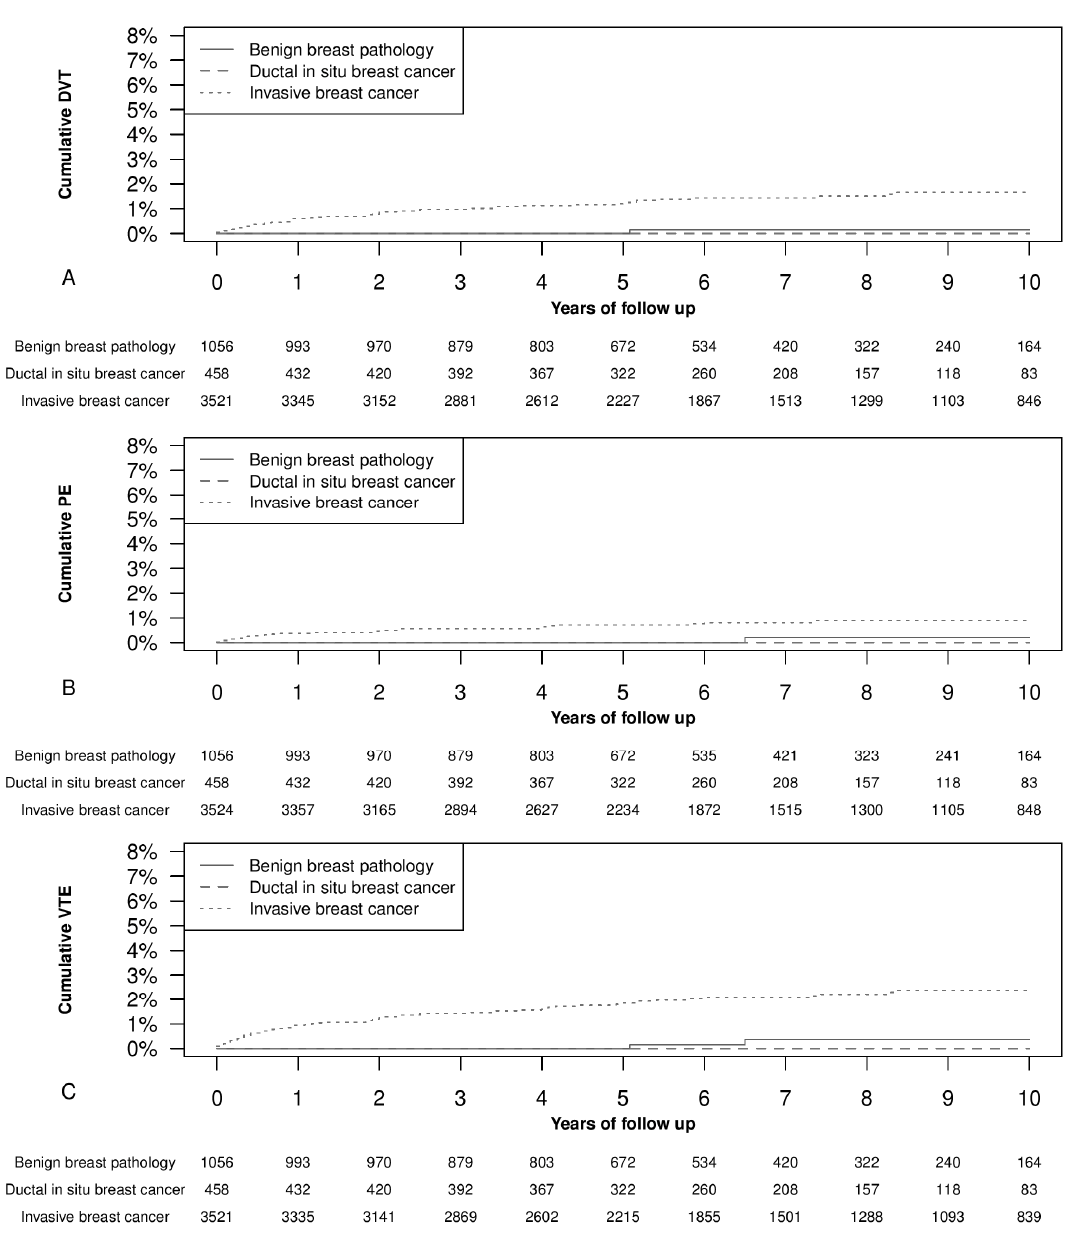
Figure 1. Occurrence of new venous thromboembolism (VTE) events in benign breast pathology, ductal carcinoma in situ breast, and invasive breast cancer. Panel ( A) shows new deep vein thrombosis (DVT) events, with a significantly higher occurrence of DVT in invasive breast cancer than in carcinoma in situ ( p < 0.05) and benign breast pathology ( p < 0.05). Panel ( B) shows new pulmonary embolism (PE) events, with a higher occurrence of PE in invasive breast cancer than in carcinoma in situ ( p = 0.063) and benign breast pathology ( p < 0.05). Panel ( C) shows new VTE events with a significantly higher occurrence of VTE in invasive breast cancer than in carcinoma in situ ( p < 0.05) and benign breast pathology ( p < 0.05). The p -values refer to log-rank